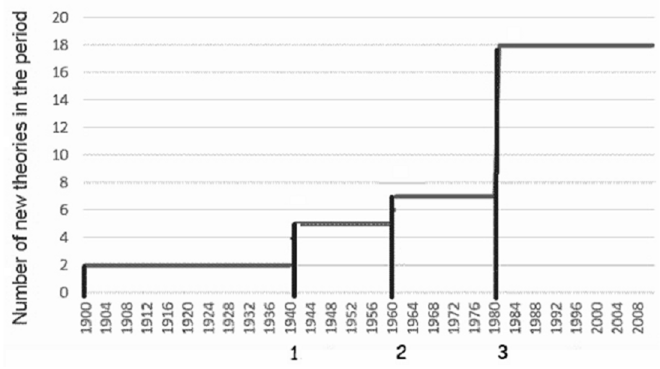
Figure 1. Number of new theories per periods of years (1 = 1941 invention of the first computer system, 2 = 1964 launch of series 360/IBM, 3 = 1981 diffusion of the personal computer—1990s inter- net).